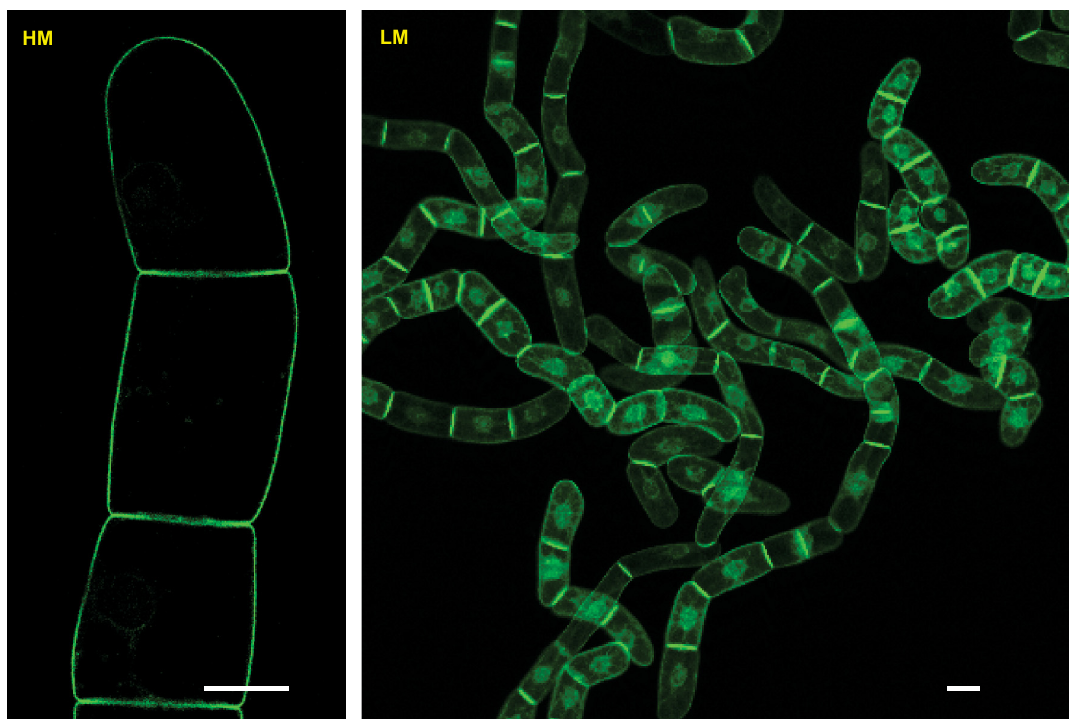
Figure 7. Clonal transgenic tobacco BY-2 cell line expressing the H -GFP-BD-CVIL fusion protein. GFP expression was induced 6 according to the previously described standard protocol. Both images were taken with a confocal laser scanning microscope (Zeiss LSM510 equipped with an inverted Axiovert 100M). HM-High magnification image taken with a 63x water immersion objective (C-Apochromat 63x/1.2W M27), which is specifically designed for the examination of an aqueous specimen and delivers high resolution in optical thin sections, with satisfying levels of fluorescence brightness. LM-Low magnification image taken with a 10x “Enhanced Contrast Plan-Neofluar” universal objective (EC Plan-Neofluar 10x/0.3 M27), adapted for general observations in fluorescence microscopy. If not otherwise stated, the label HM and LM designates the use of these both types of objectives for the image acquisition with the confocal laser scanning microscope. White bars = 20µm. Please, note the different saturation of the images and the significantly higher saturation in the LM image that was used to highlight the homogenous levels of bright fluorescence of the re-selected clonal cell